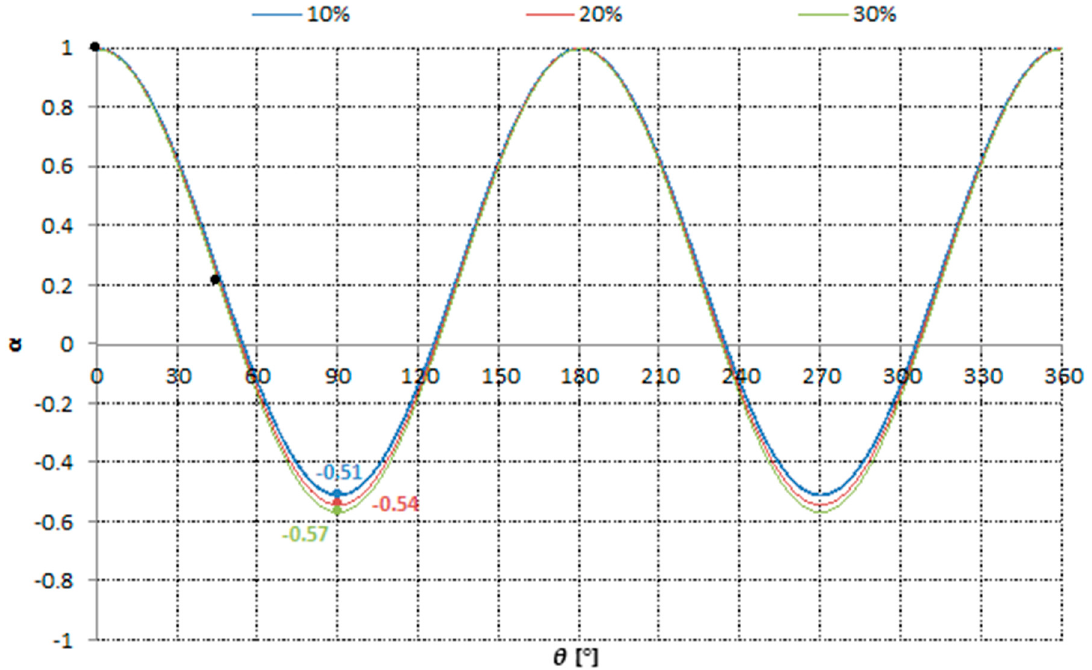
Figure 6. Evolution of α for sequential uniaxial tensile loading as function of θ [°].